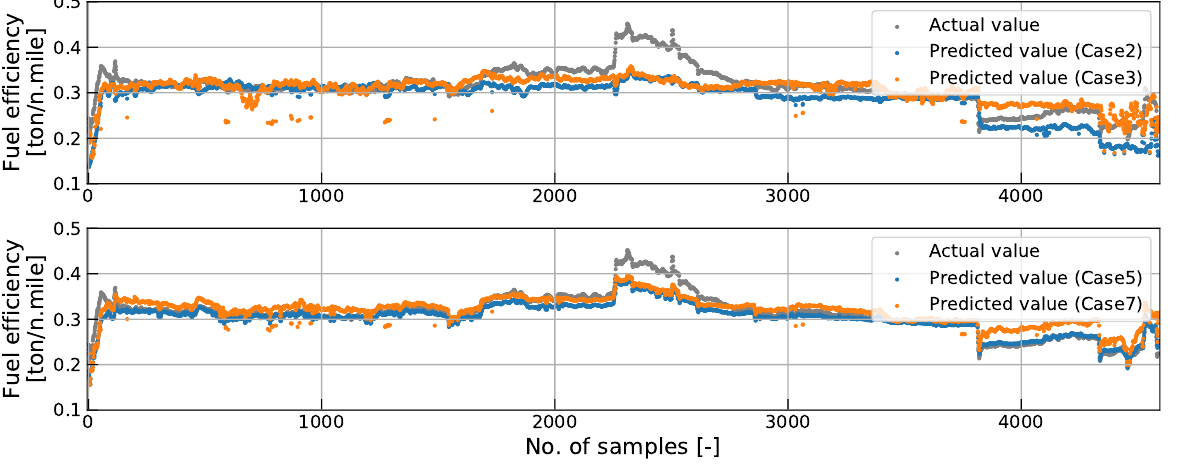
Figure 11. Prediction results of developed models for the time-series data. Over the 1414.85 nautical miles sailed by the target ship from Yantian to Singapore, the actual fuel consumption was 445.8 tons. The model with Cases 2, 3, 5, and 7 predicted values of 413.6, 436.0, 431.0, and 453.5 tons, respectively, i.e., prediction errors from −